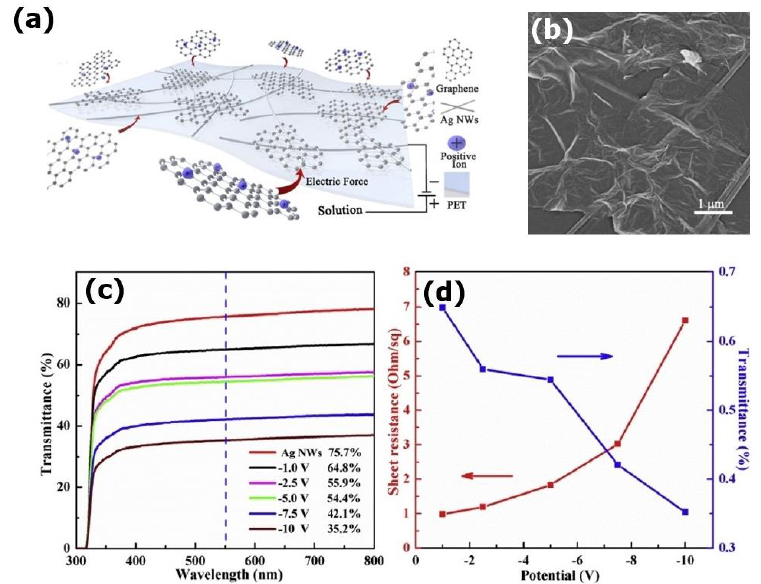
Figure 14. ( a ) Schematic illustration of the mechanism to fabricate Ag nanowire/graphene material on a polymer substrate by electrophoresis. ( b ) SEM of the obtained electrode morphology. ( c ) The transmittance of the flexible electrode depends on applied electrophoresis voltage but is constant throughout the optical regime. ( d ) The sheet resistance is well below that of ITO, while the transmittance is still too low for state-of-the-art electro-optic devices. (Reproduced by permission from [166]).